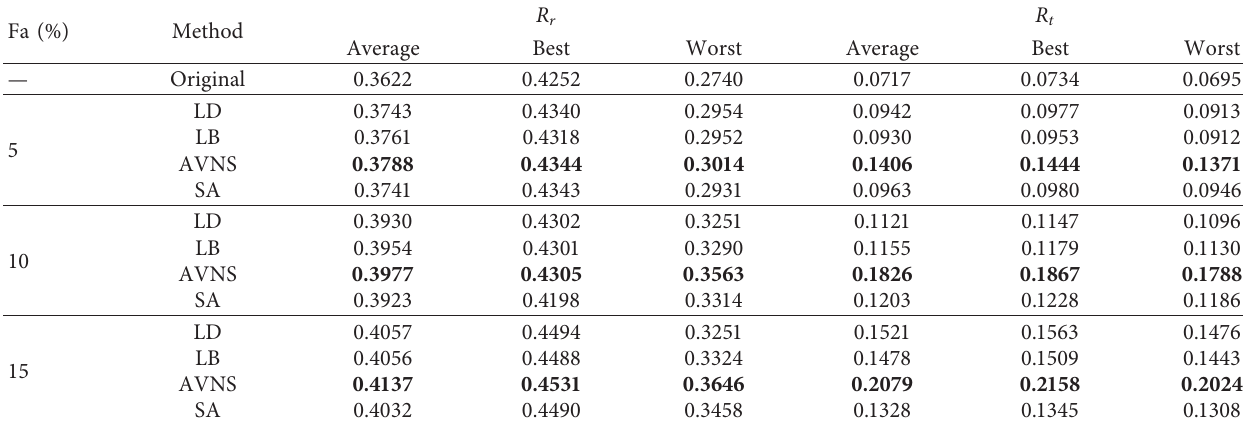
Table 4: Robustness comparison of chain 25 and reconfigured